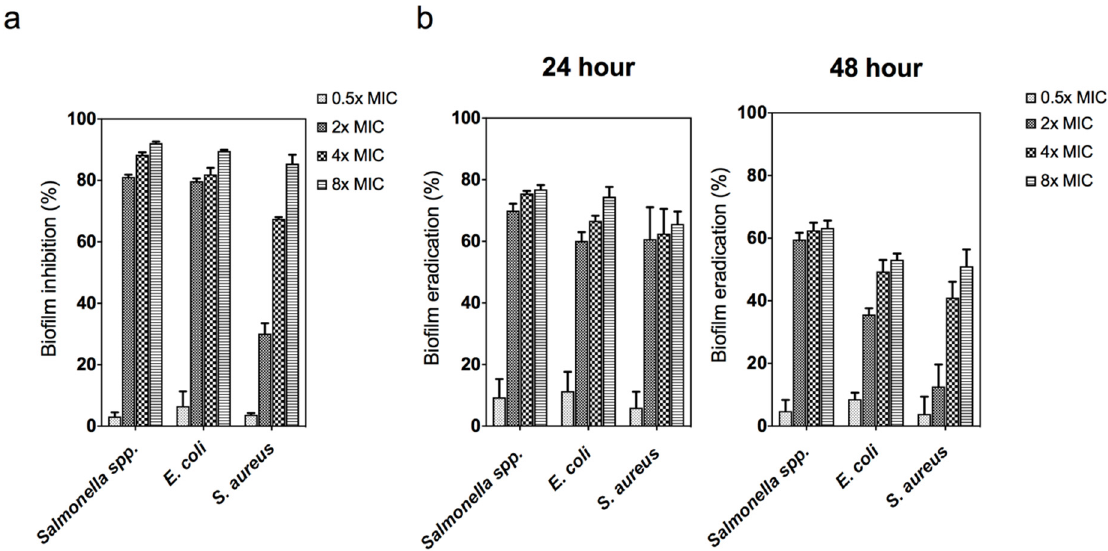
Figure 4. ( a ) Biofilm inhibitory following treatment with ZnO NPs 0.5 × , 2 × , 4 × , and 8 × minimum inhibitory concentration (MIC) against Salmonella spp., E. coli , and S. aureus . ( b ) Biofilm eradication at 24 h and 48 h following treatment with ZnO NPs 0.5 × , 2 × , 4 × , and 8 × MIC against Salmonella spp., E. coli , and S. aureus . Biofilm was assessed by crystal violet staining and measured at an absorbance of 590 nm. The data represent the mean ± SD of three